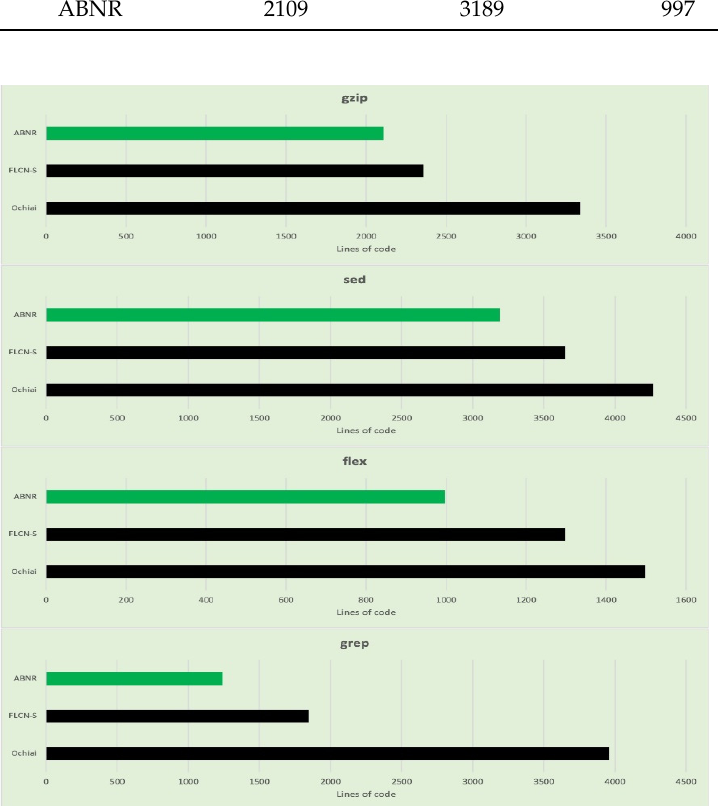
Figure 6. Graphs representing the number lines of code evaluated for fault localization for each category in the Unix utility program .